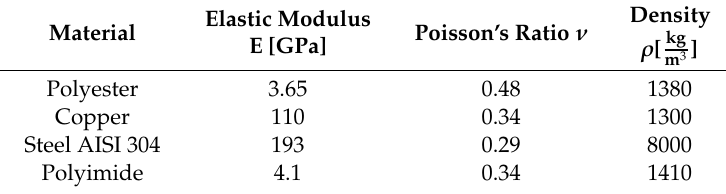
Table A1. Substrate materials properties.